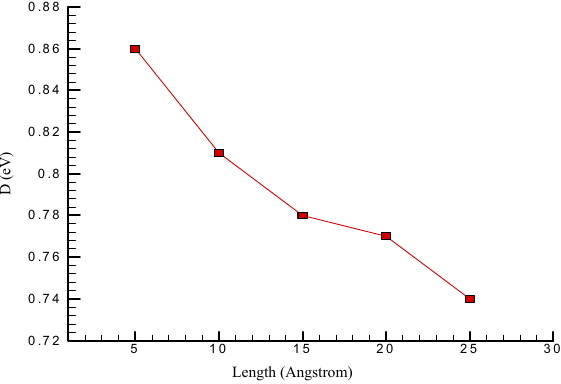
Figure 7. Bending Stiffness changes of carbon nanotubes versus length of nanotubes.